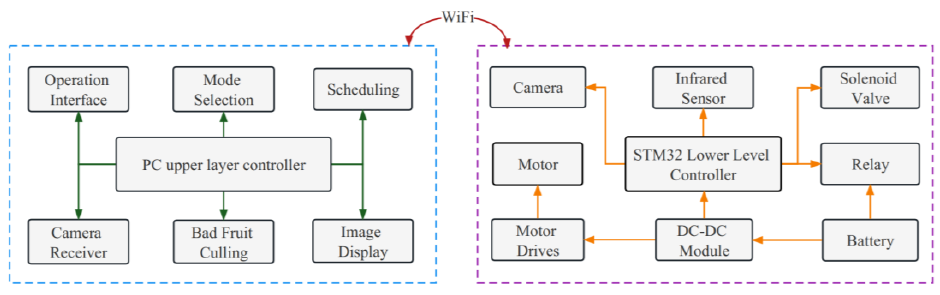
Figure 22. Control architecture for machines.